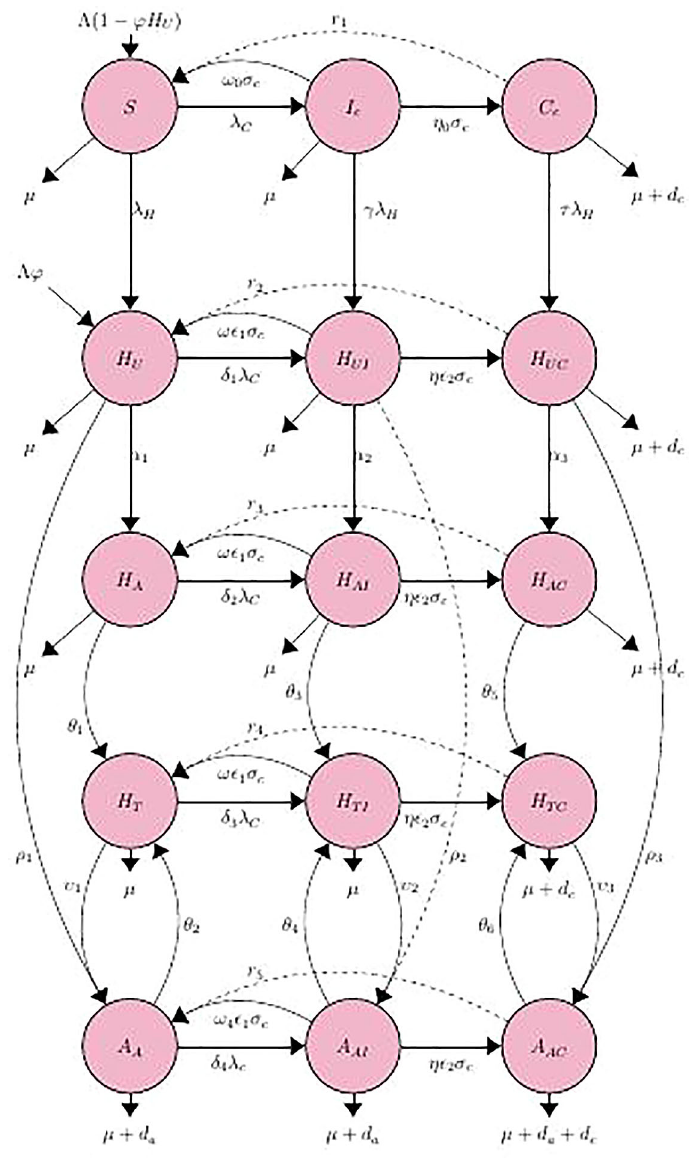
Figure 1. The compartmental flow diagram of the HIV-HCV